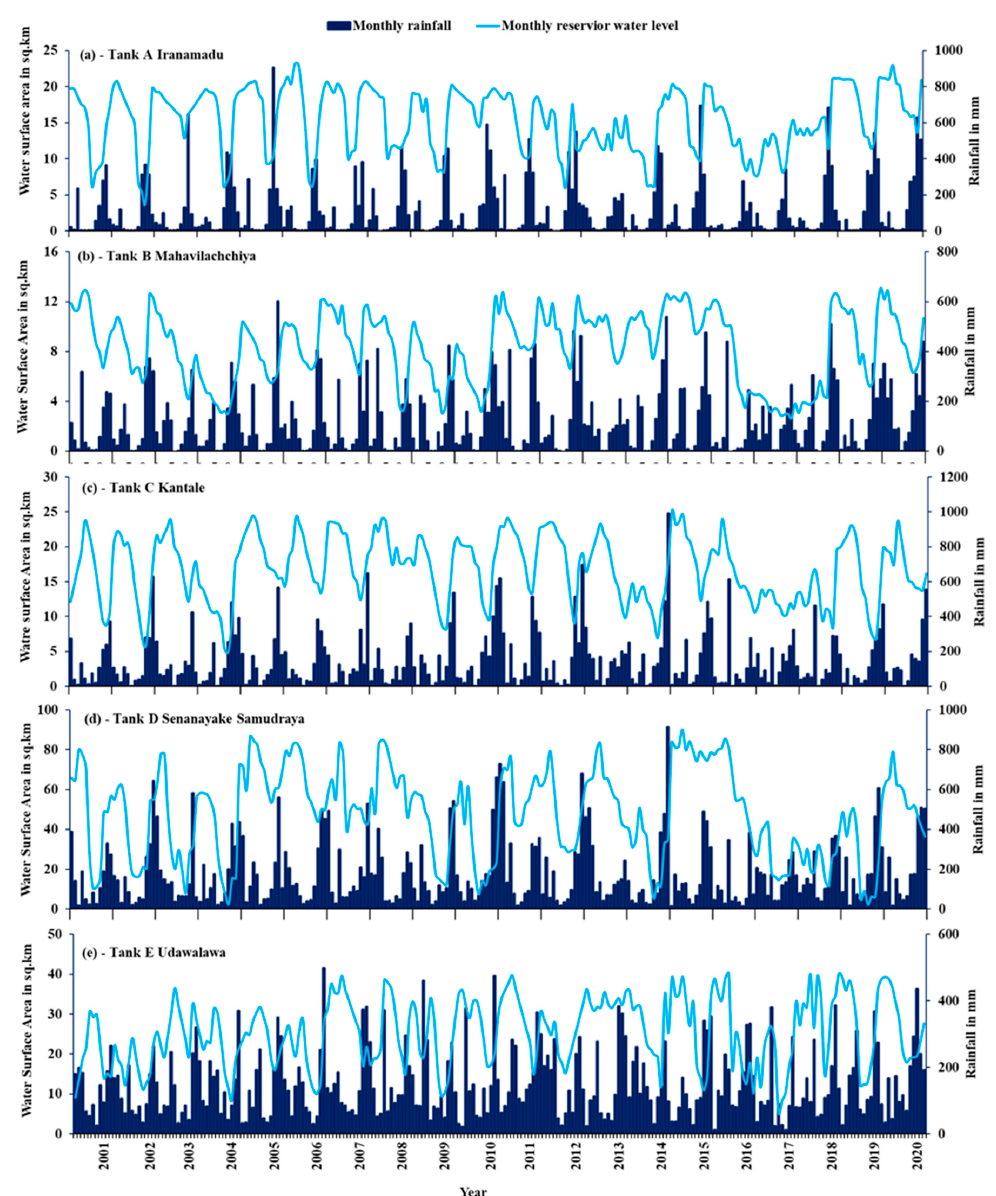
Figure 7. Rainfall and tank water level changes from 2001 to 2020. ( a )—Tank A (Iranamadu), ( b )—Tank B (Mahavilachchiya), ( c )—Tank C (Kanthale), ( d )—Tank D (Senanayaka Samudraya), ( e )—Tank E (Udavalawa).